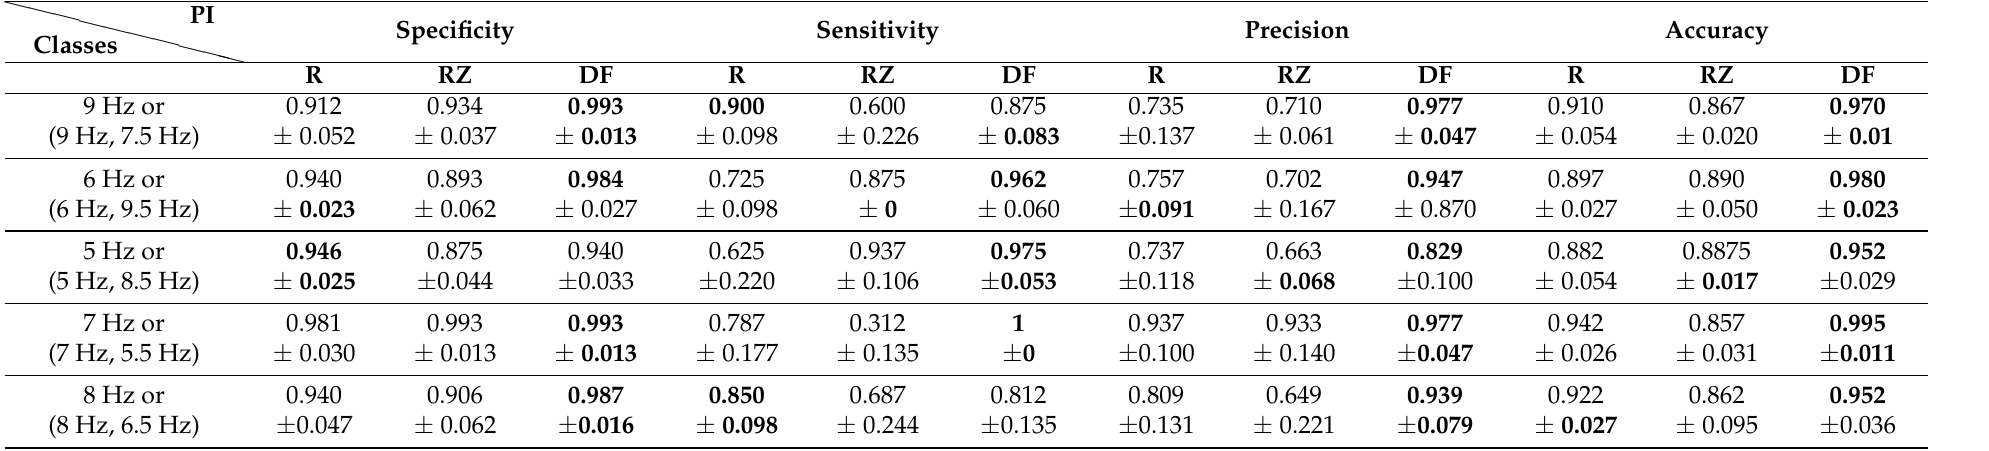
Table 2. Comparison between mean and standard deviation values associated with performance indices (precision, sensitivity, specificity, and accuracy across) all run for three paradigms, i.e., Rotation (R), Radial Zoom (RZ), and the proposed DF-SSmVEP (denoted by